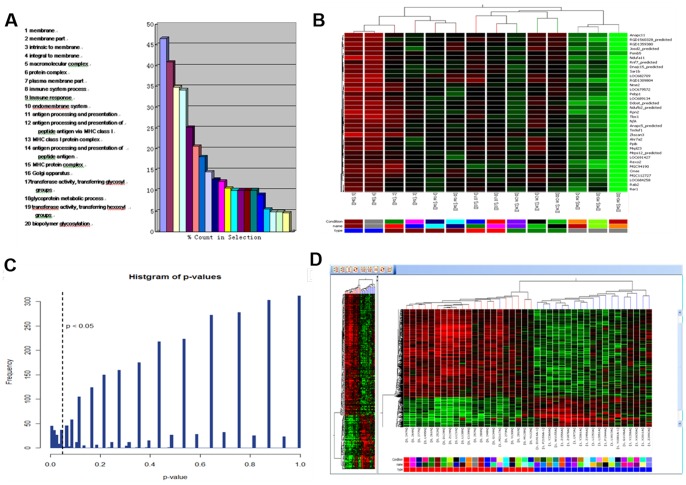
Microarray results.(A) GO classification showing genes involved in different molecular function categories. (B) Two-way hierarchical clustering analysis. (C) P values in Mann-Kendall trend Monotone test. (D) Homologous genes in rat and human at different stages of the rat model.